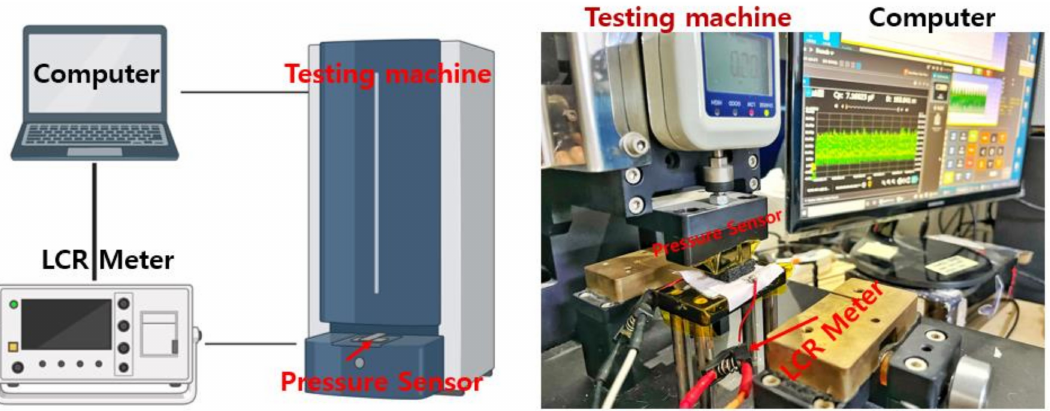
Figure 7. Schematic of the universal testing machine and measurement setup for presented pressure